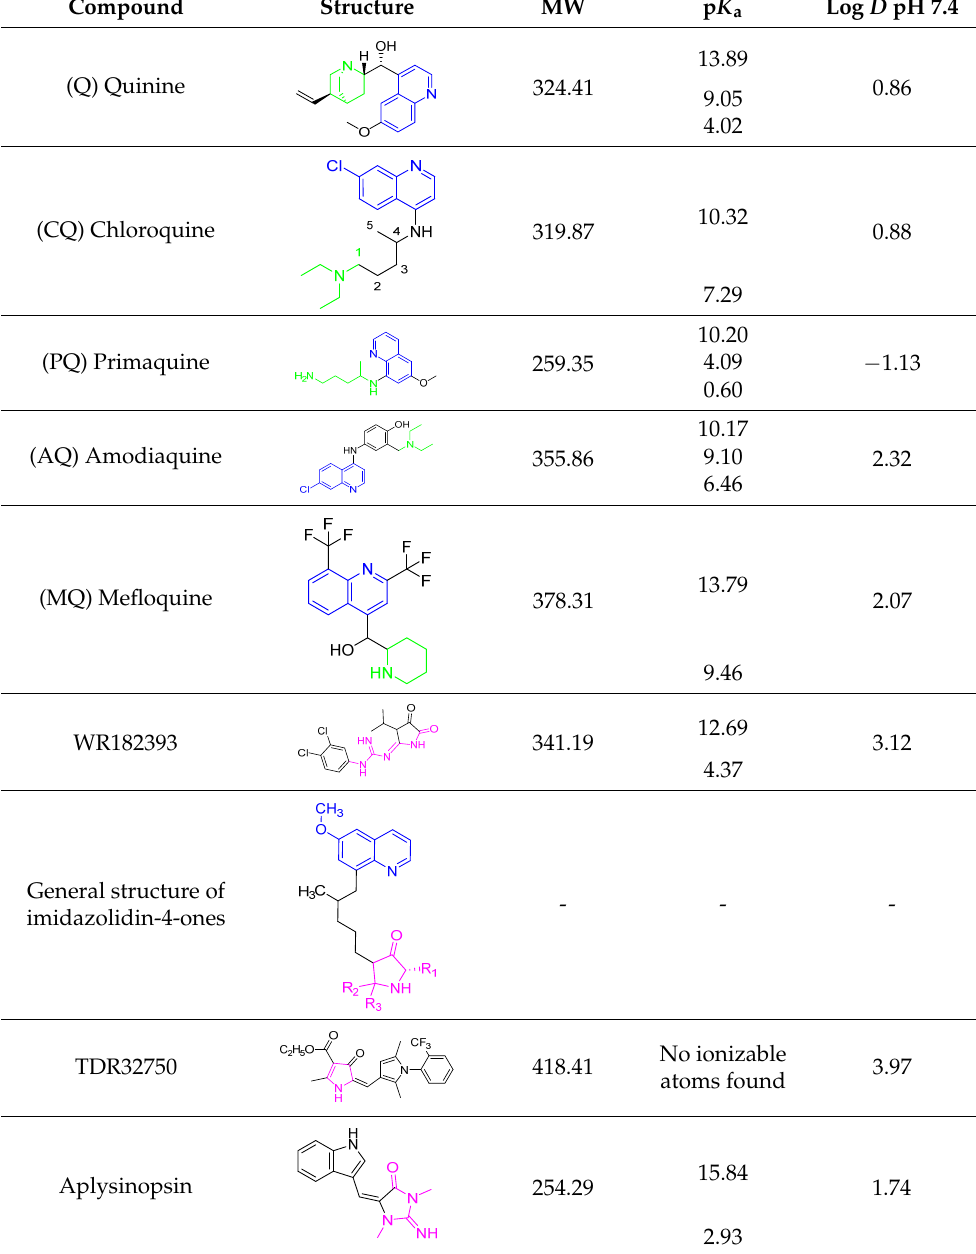
Table 1. Antimalarial drugs based on a 4-aminoquinoline scaffold and compounds from references [2–11]. Chemical structures and physicochemical properties.